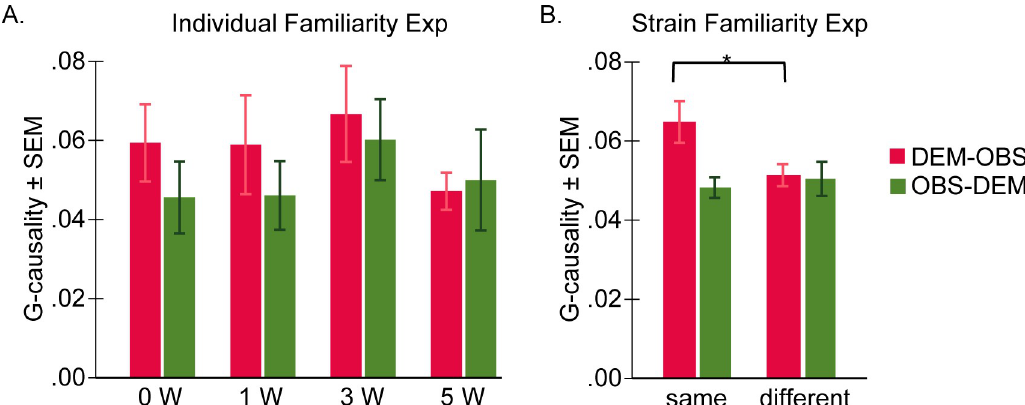
Fig 7. Directionality of information transfer. (A) G-causality results. Mean ± SEM for G-causality values for the demonstrator- to-observer direction (DEM–OBS, in red) and the observer-to-demonstrator direction (OBS–DEM, in green) during the shock period, for the individual familiarity experiment. (B) G-causality results for the strain familiarity experiment. Data can be found at http://dx.doi.org/10.17632/h8fkyr2z35.1. DEM, demonstrator rat; different, different strain; Exp, experiment; G-causality, Granger causality; OBS, observer rat; same, same strain; SEM, standard error of the mean; W, week.